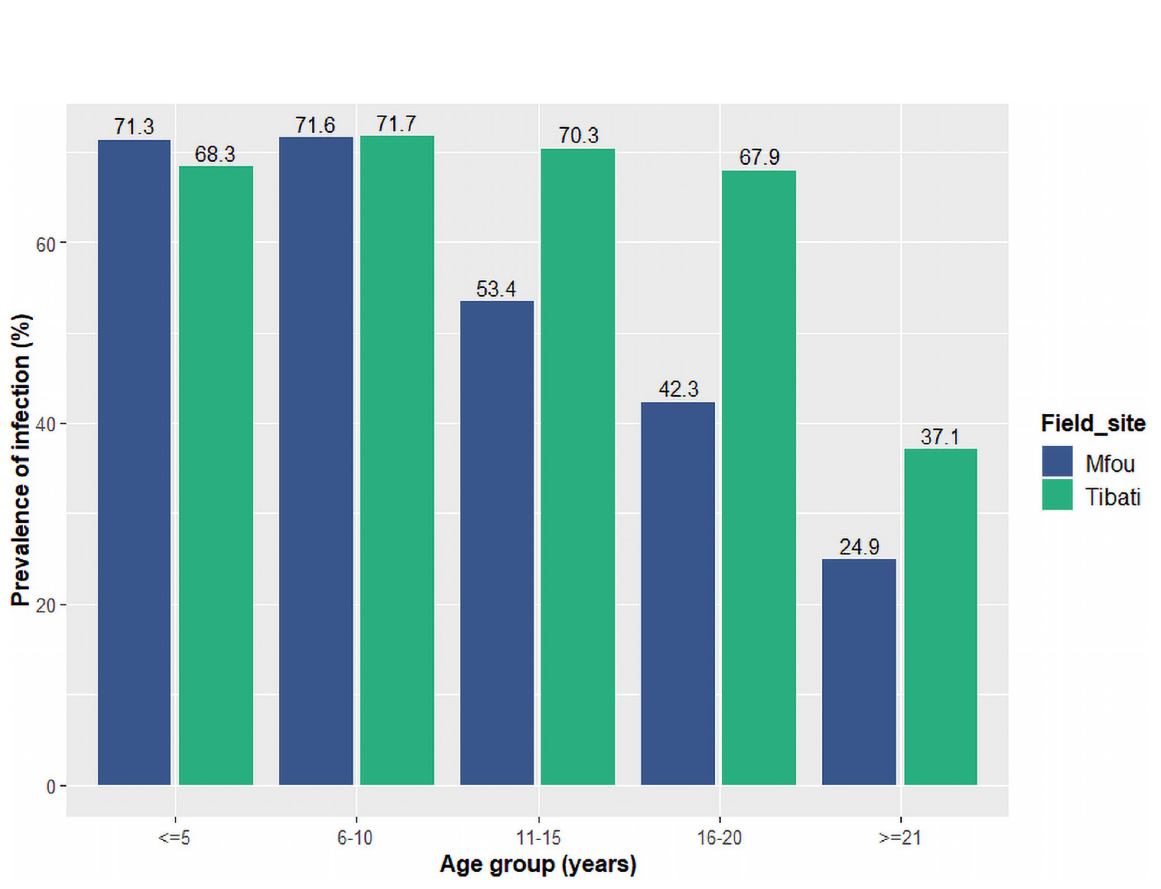
Fig 2. Distribution of Plasmodium infections among age groups in Mfou and Tibati. In Mfou, the infection prevalence steadily decreased by age group and reached 24.9% in the age group � 21 years. In Tibati, the prevalence remained close to 70% in all age groups and only dropped in the age group � 21 years to